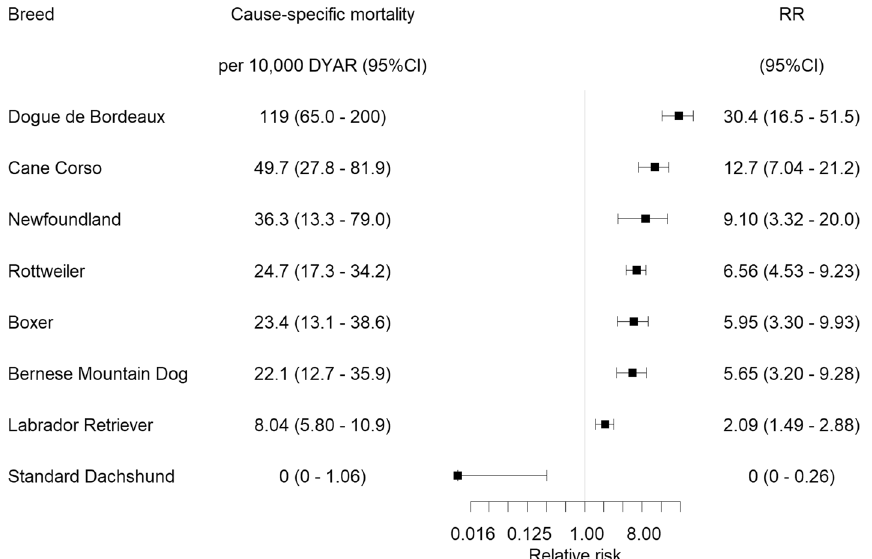
Figure 2. The breeds with increased or decreased relative risk (RR) of death/euthanasia due to cruciate ligament rupture (relative to the rest of the population with the breed excluded) in a cohort of dogs insured in Agria Pet Insurance in Sweden during 2011–2016. All RRs in the figure were significantly different from 1, after Bonferroni correction based on the number of breeds included in the comparison, n = 335. Note that RR = 0.5 means 2 times decreased risk, RR 0.125 means 8 times decreased risk and so on. A fudge factor of 0.01 was added to the RR of Standard Dachshund in order to present the RR on the log-scaled x axis. DYAR dog-years at risk, CI confidence